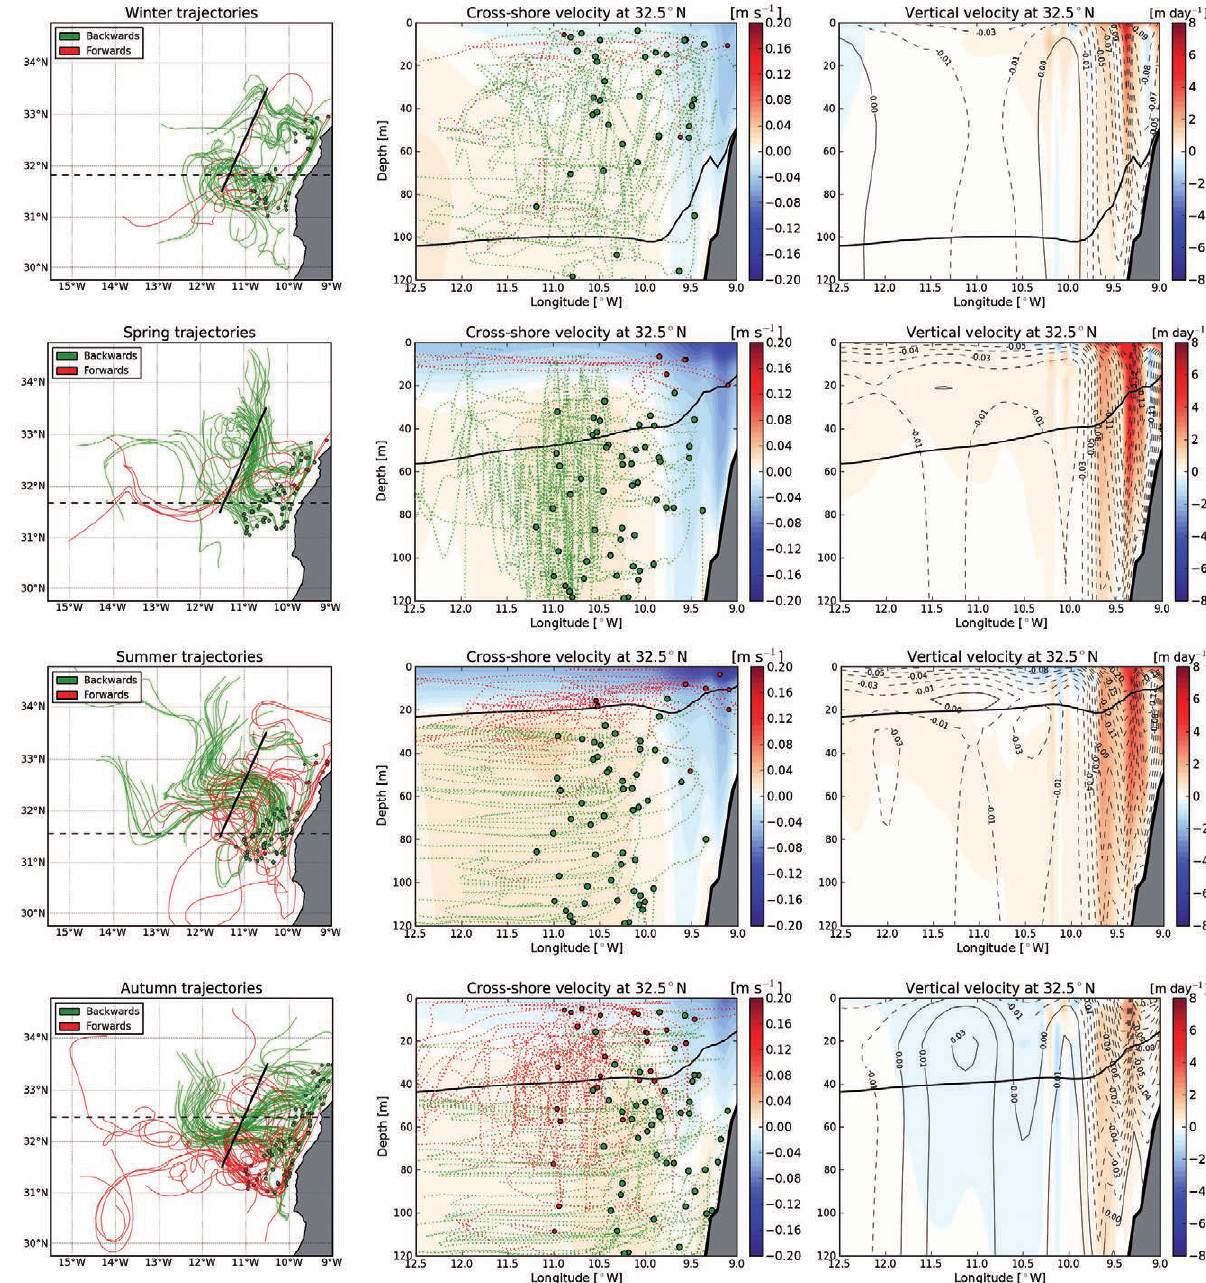
over the following seasons to a low of 13% in